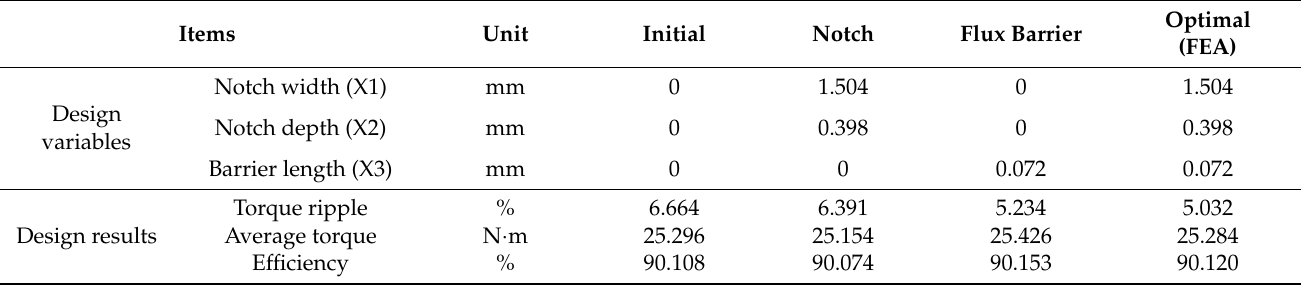
Figure 8. Cogging torque waveforms of the initial and optimal models. Table 6. Analysis results of design variables for the notch and flux